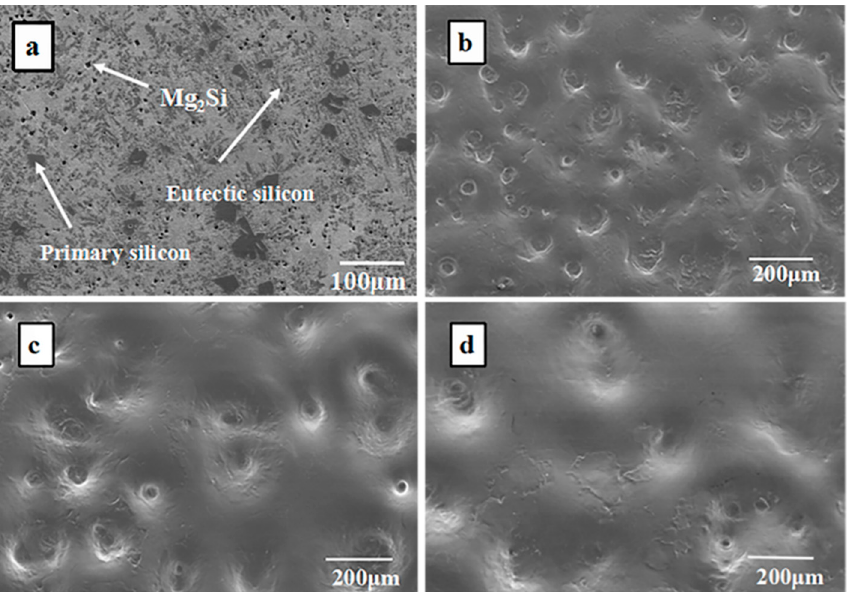
Figure 1. Scanning electron microscopy (SEM) morphology images of Al–20Si–5Mg alloy before and after high-current pulsed electron beam (HCPEB) treatment: ( a ) Initial sample, low magnification; ( b ) 5 pulses, high magnification; ( c ) 15 pulses, high magnification; and ( d ) 25 pulses, high magnification.